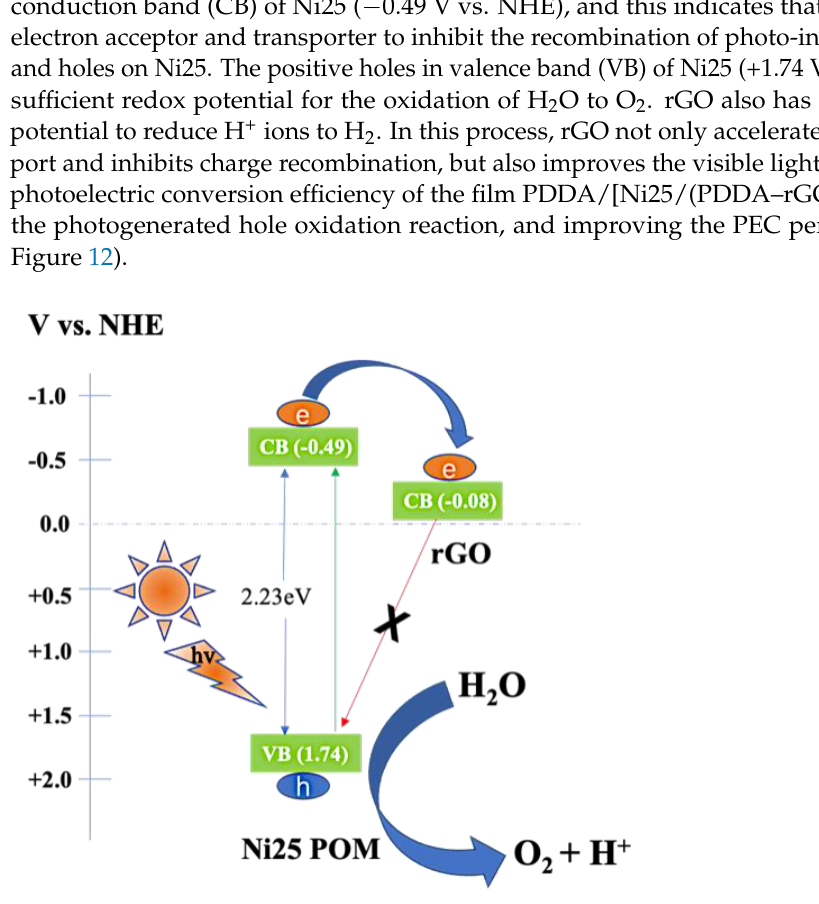
Figure 12. Plausible mechanism of photoelectrocatalytic water oxidation.